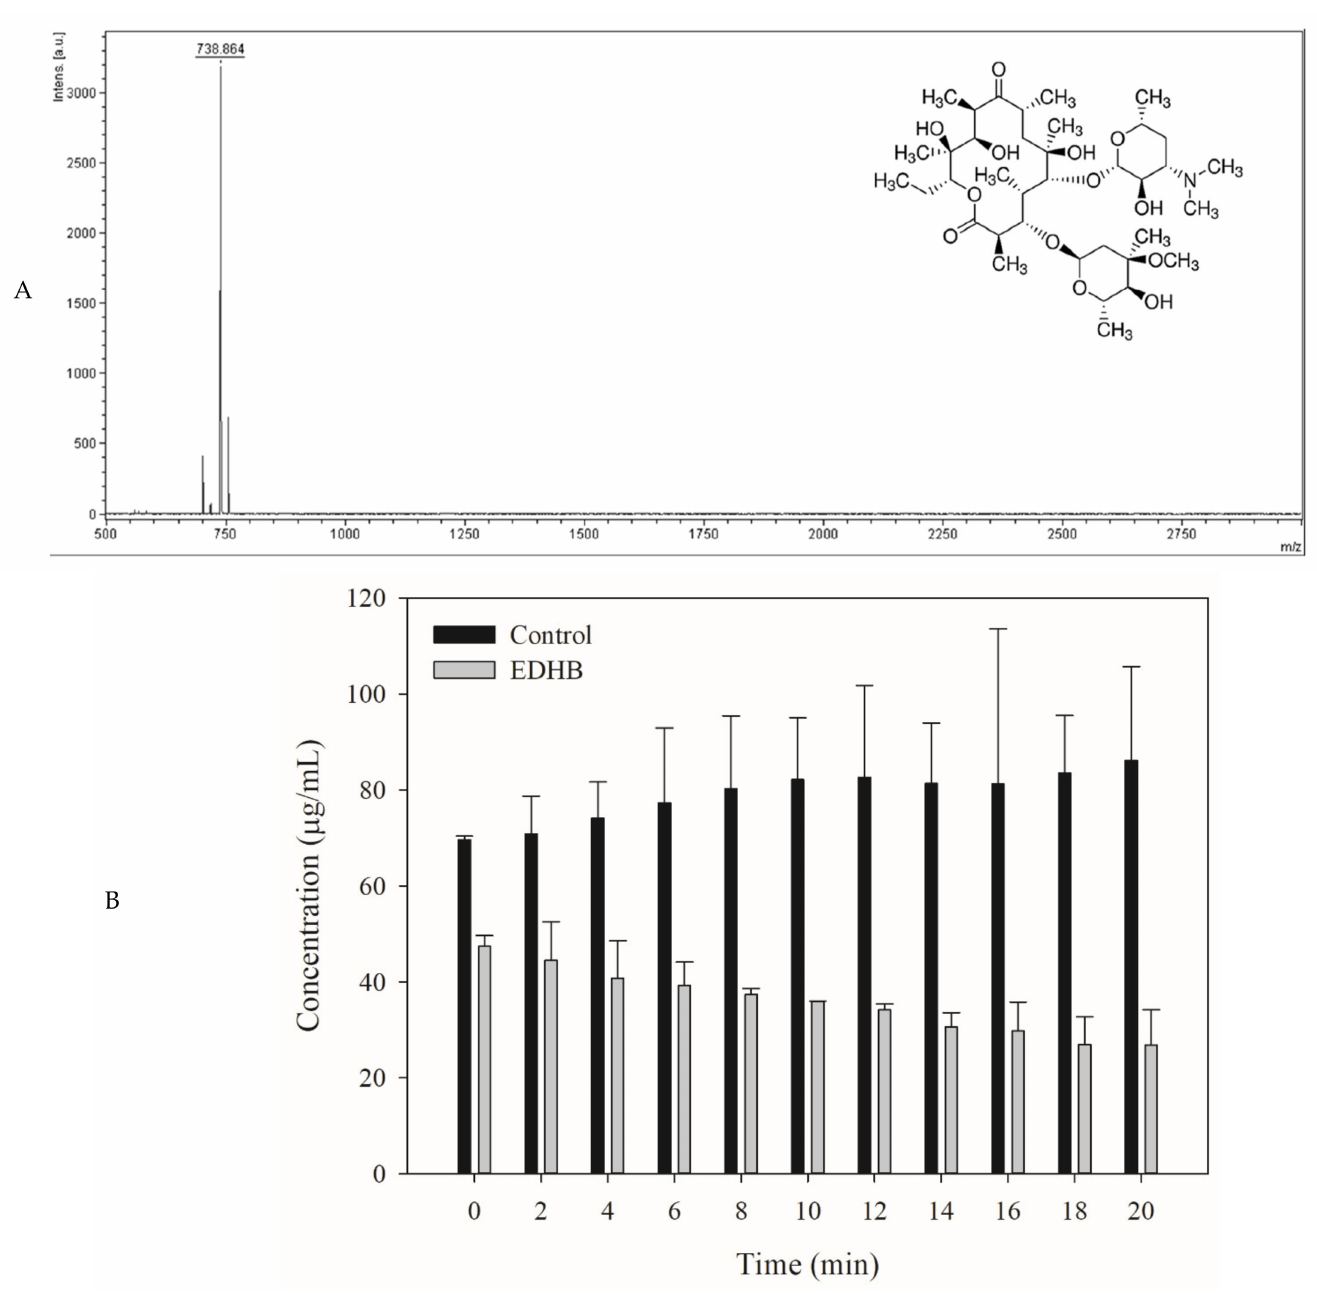
Figure 4. The erythromycin efflux activity of E. coli Kam3-AcrB was detected by using MALDI- TOF MS in the presence of EDHB. ( A ) The mass spectrum of erythromycin and ( B ) the intensity of extracellular erythromycin. The intensity was plotted at the main peak at m/z 738.35 of erythromycin, and the detection period was 20 min. Values are expressed as mean ± SD ( n =